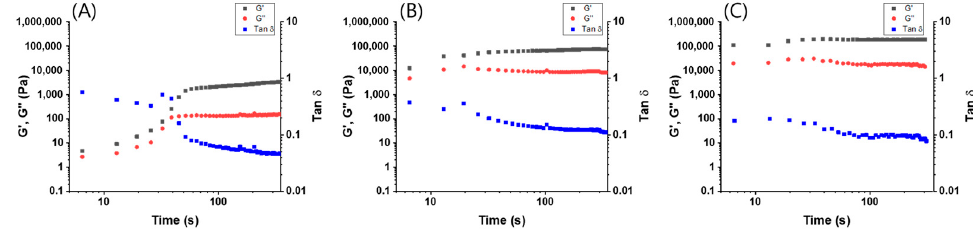
Figure 4. Time sweep (frequency = 0.6283 rad s − 1 ) of gels obtained from ( A ) 1 (1 wt %) + 2 (2 equiv.), ( B ) 1 (3 wt %) + 2 (2 equiv.) and ( C ) 1 (5 wt %) + 2 (2 equiv.) in toluene. ( B ) 1 (3 wt %) + 2 (2 equiv.) and ( C ) 1 (5 wt %) + 2 (2 equiv.) in